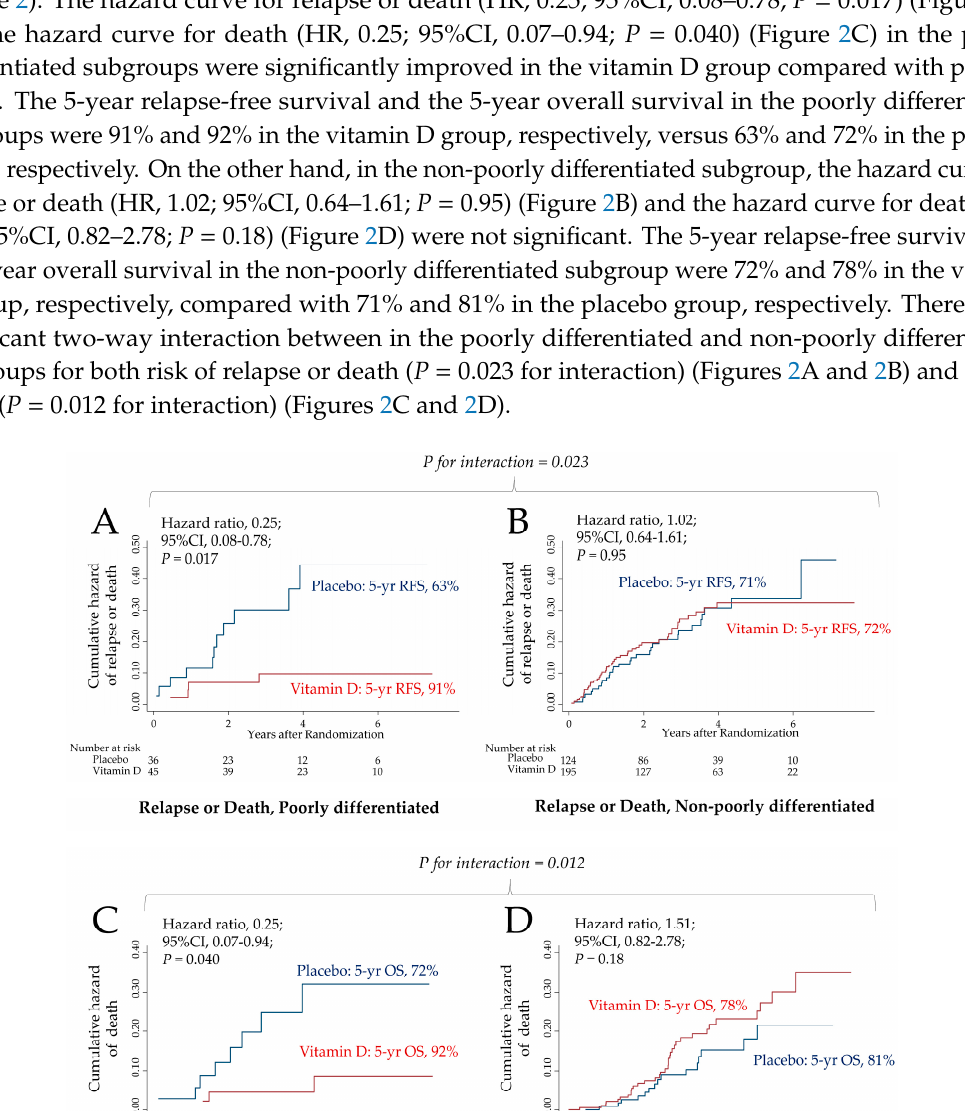
di ff erentiated subgroup in which the patients did not have poorly di ff erentiated adenocarcinoma (Figure 2). The hazard curve for relapse or death (HR, 0.25; 95%CI, 0.08–0.78; P = 0.017) (Figure 2A) and the hazard curve for death (HR, 0.25; 95%CI, 0.07–0.94; P = 0.040) (Figure 2C) in the poorly